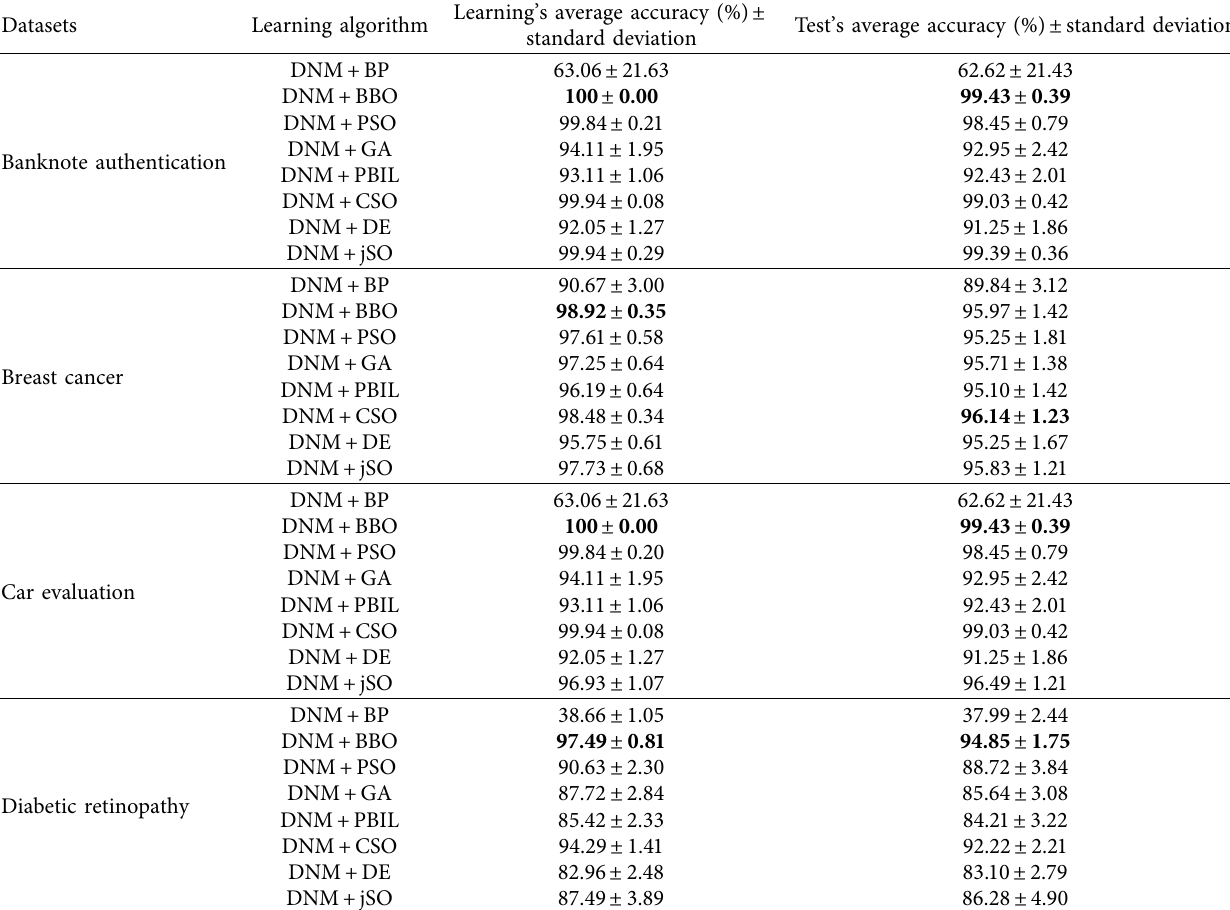
Table 5: Average accuracy and standard deviation of each learning algorithm.